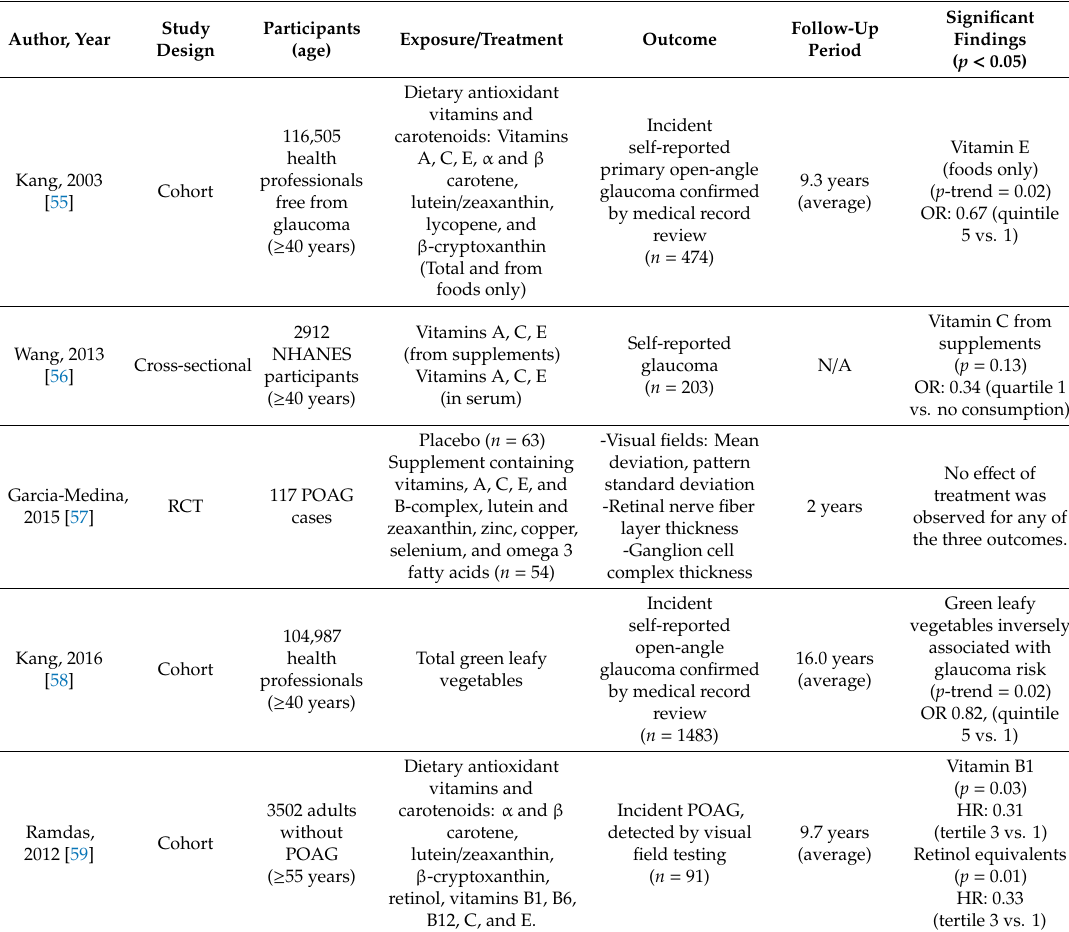
Table 1. Summary of human studies of dietary antioxidants (and antioxidant food sources) and primary open-angle